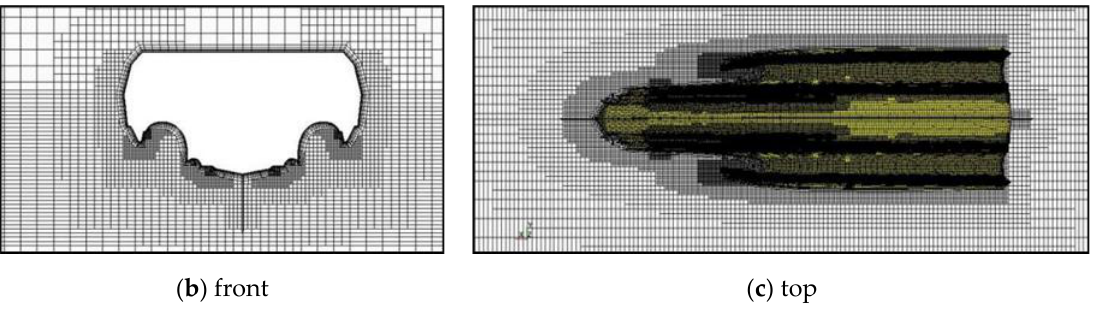
Figure 2. Generated mesh. The upper row shows the longitudinal view of the cells around the body from a longitudinal view. The lower panels show the generated cells from side, front, and top views. The vessel that is shown here is named Model B, which is introduced in Section 3.4. The generated mesh has 1,291,035 cells (Grid C).